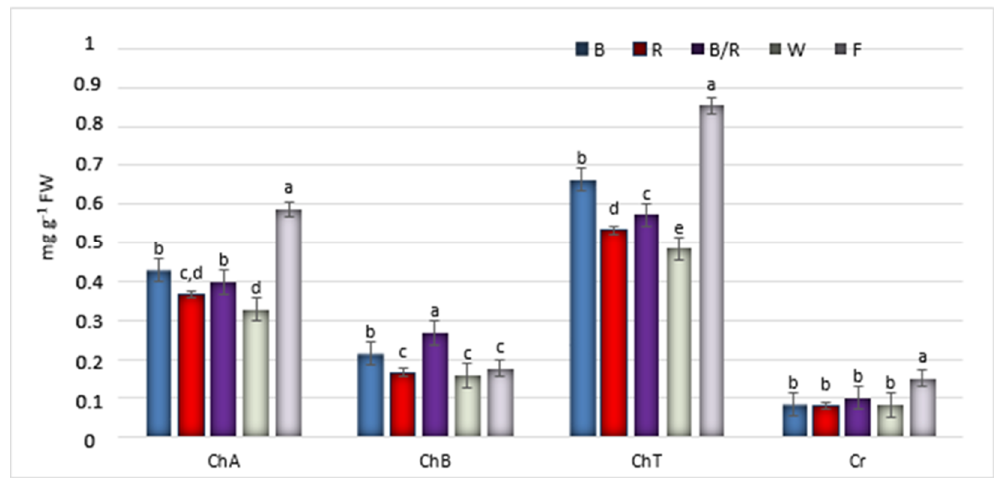
Figure 5. The effect of light conditions: (B) blue, (R) red, (B/R) blue/red, (W) white, (F) fluorescent on the photosynthetic pigments contents (mg g −1 FW) in shoots of D. forrestii . The values represented means ± SE of three independent experimental replicates. The means marked with various letters for the same parameter were different at p < 0.05 according to one way ANOVA test followed by the post-hoc Tukey’s test. (ChA) chlorophyll A, (ChB) chlorophyll B, (ChT) total chlorophyll, (Cr) carotenoids.